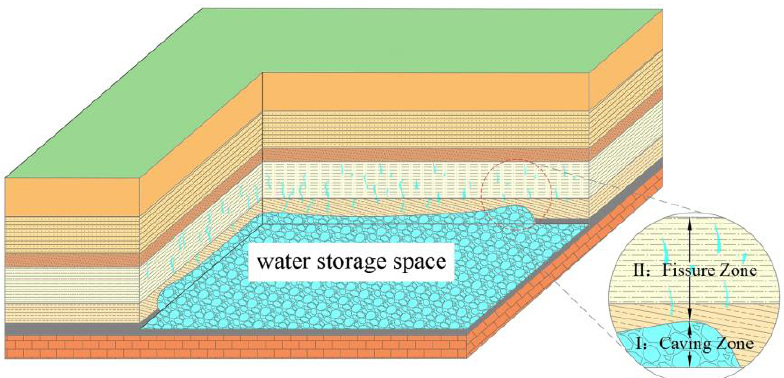
Figure 2. Schematic diagram of the main water storage space (wherein: I: Caving Zone; II: Fissure Zone; the light blue area is the main water storage